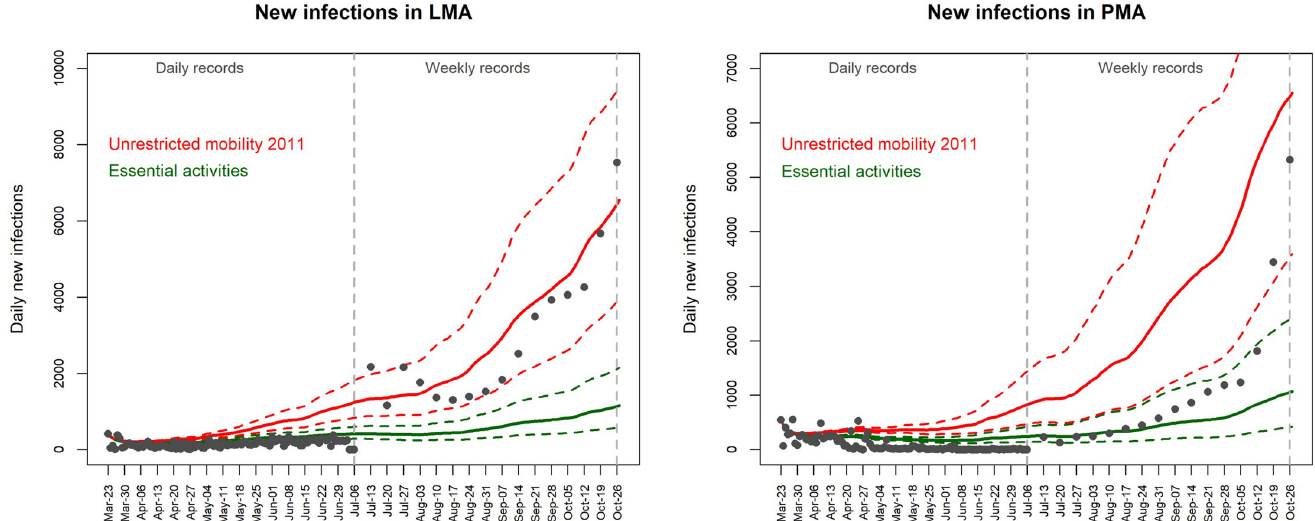
Fig 6. Simulated number of daily new infections for the scenarios regarding unrestricted mobility 2011 and mobility restricted to essential activities, between 23 rd March and 26 th October 2020, in the metropolitan areas of Lisbon (LMA, left) and Porto (PMA, right). Estimated values considering the upper and lower thresholds of the confidence interval (95%) of R t are represented as dashed lines. Official recorded cases of new infections are represented as points, daily values until the 6 th July, and cumulative weekly values afterwards.